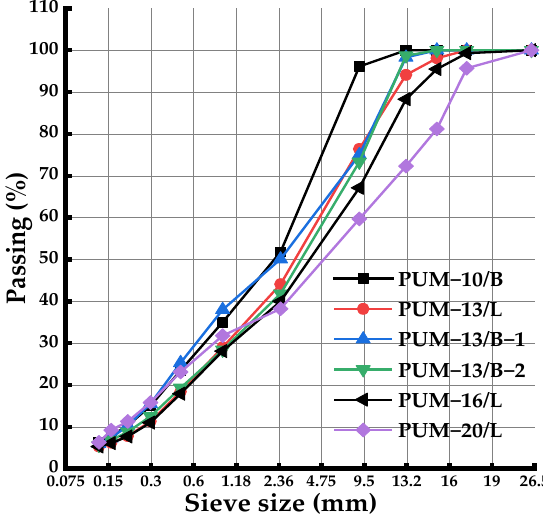
Figure 1. The gradation results of the selected dense gradation.